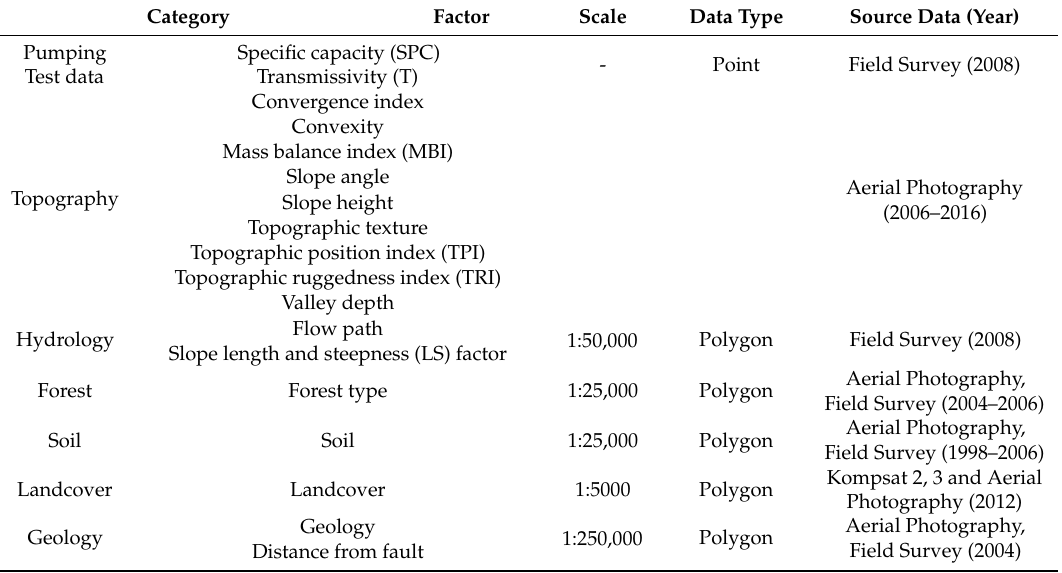
Table 1. Data layers describing groundwater